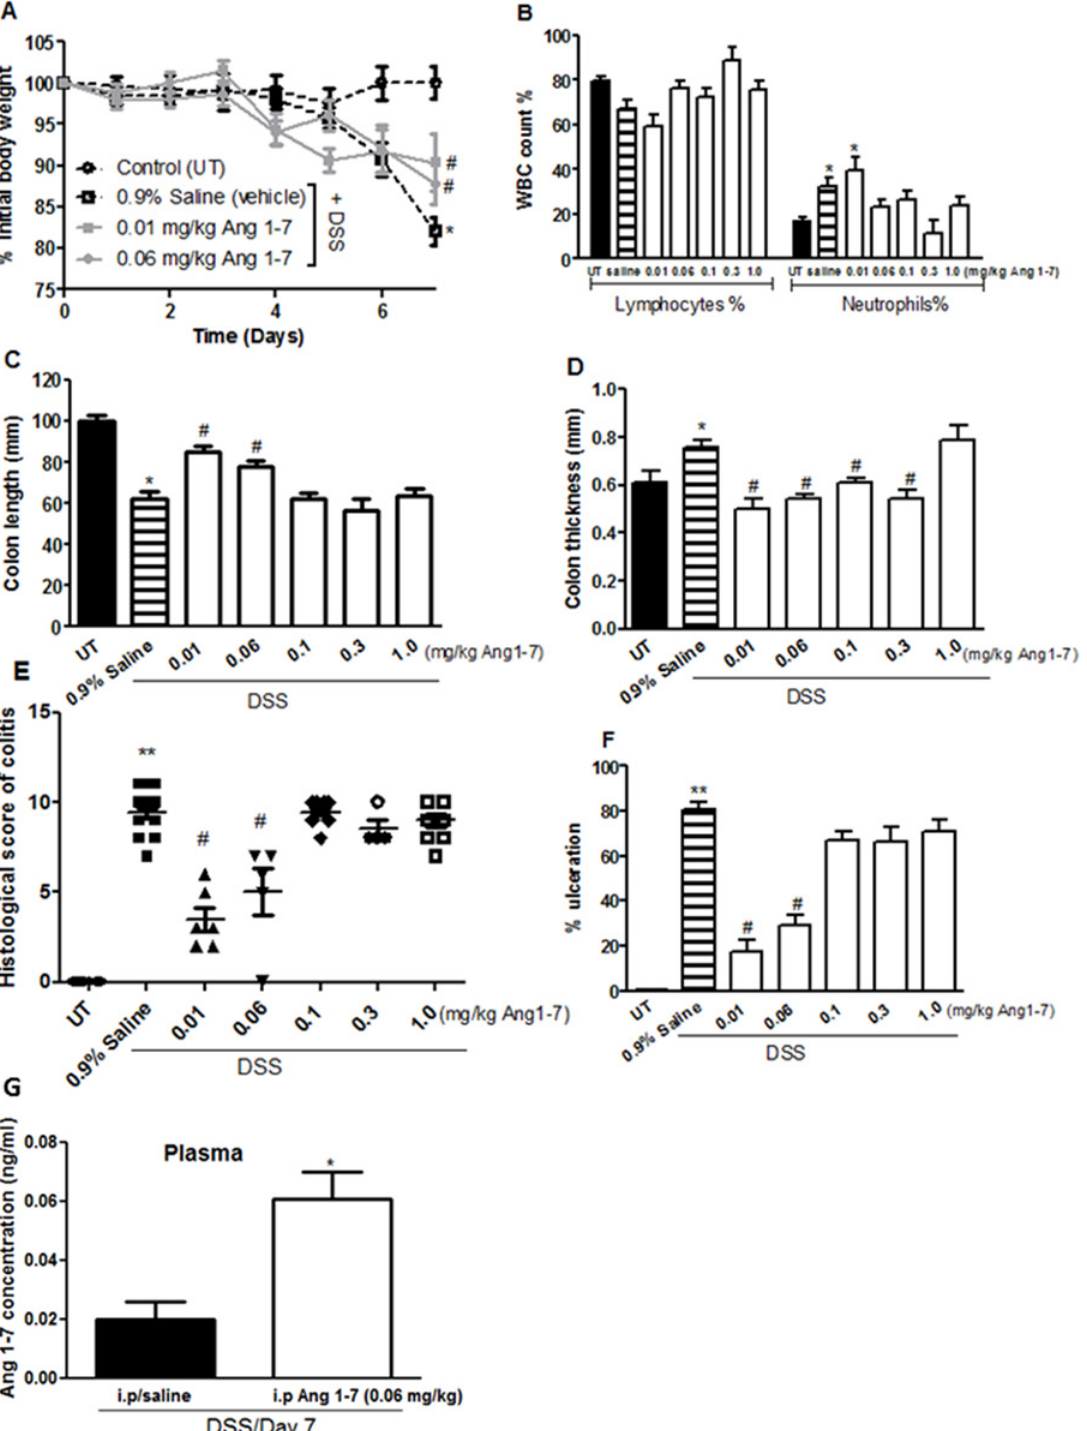
Fig 3. Effect of Ang 1 – 7 treatment on colitis severity. Panel A shows % body weight changes in saline (hatched line, open squares) or Ang 1 – 7 treated mice (gray lines) after DSS administration compared to untreated (UT) mice receiving tap water only (hatched line, open circles). Panel B shows % of circulating lymphocytes and neutrophils determined at day 7 post colitis induction in saline (hatched bars) or Ang1-7 treated mice (open bars) compared to UT group (solid bars). Colon length (panel C) and thickness (panel D) was determined in saline (hatched bars) or Ang1-7 treated mice (open bars) compared to UT group (solid bars). Panels E and F represent histological assessment of colitis severity and the % of ulceration in the whole colon section respectively in